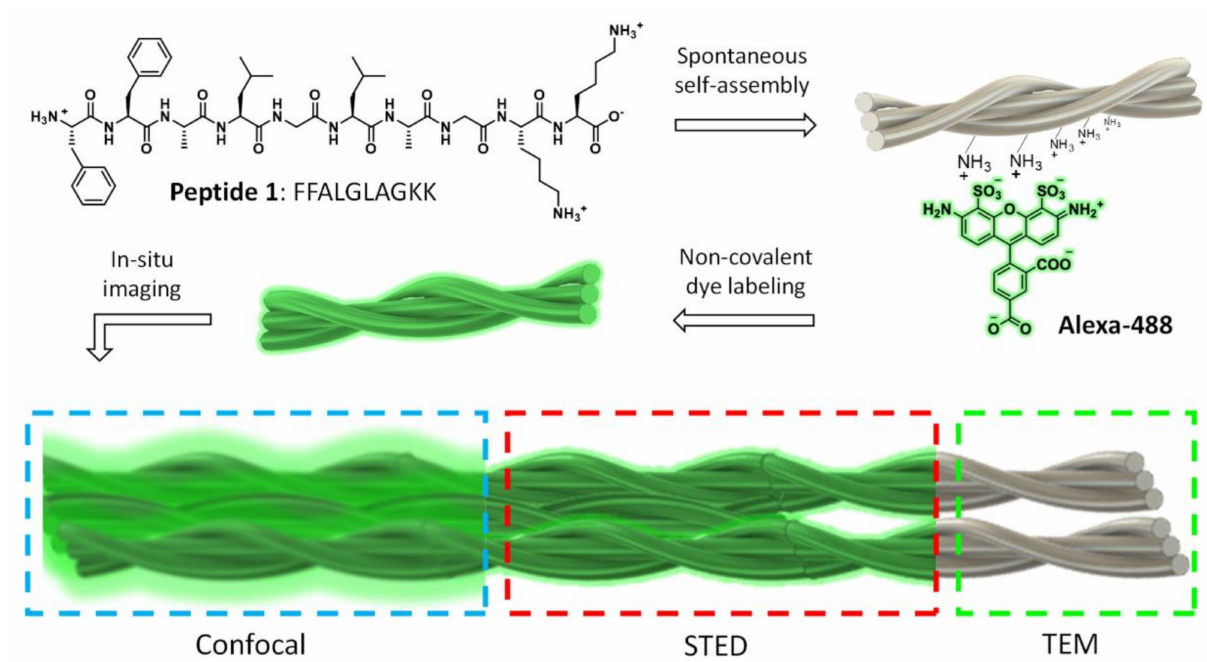
Figure 7. Schematics illustrating three different characterization methods for peptide-based nanostructures, including non-covalent labeling with a fluorescent dye (Alexa-488): confocal (fluorescence) microscopy, stimulated emission depletion (STED), and transmission electron microscopy (TEM) with different levels of resolution for the nanofibers. Reproduced with permission from [82] ©2020, American Society of